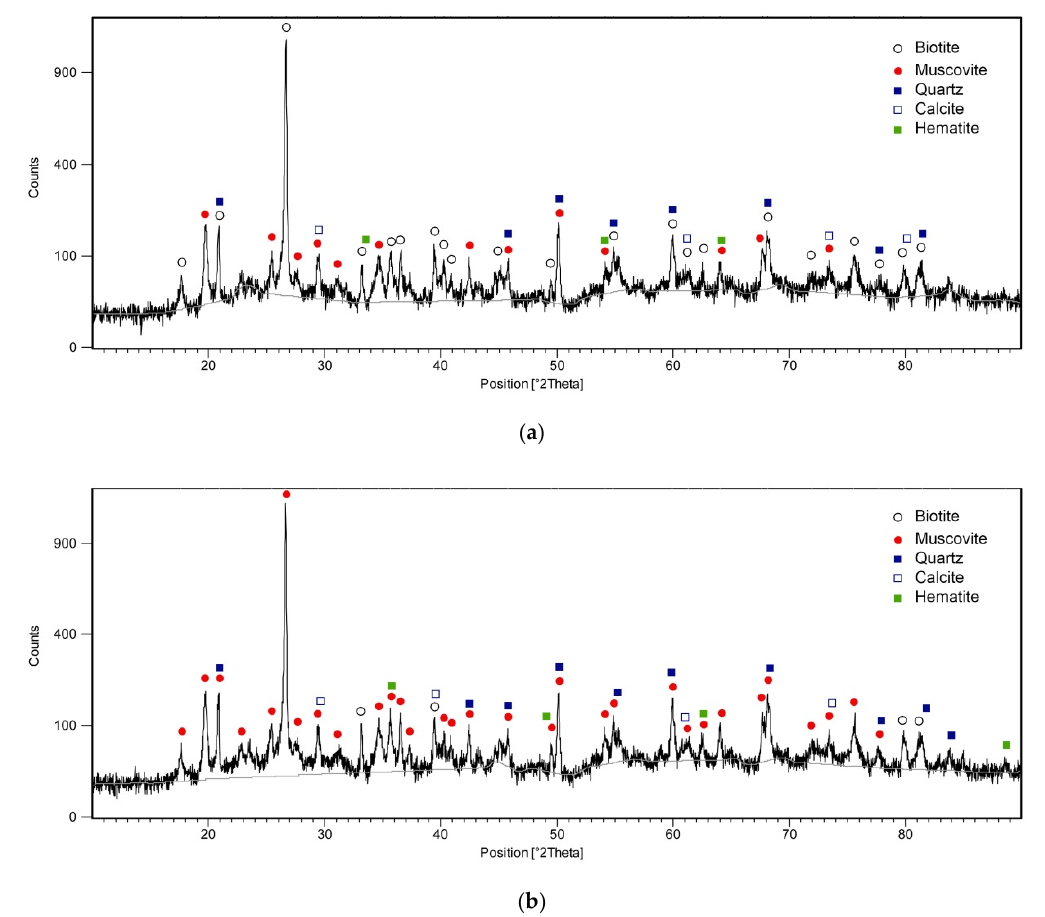
Figure 2. X-ray diffraction patterns of ( a ) the starting material and ( b ) synthesized muscovite.